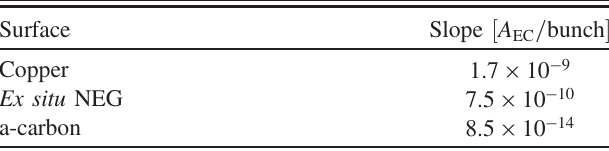
TABLE II. Slopes of the pressure increase as a function of the number of bunches.